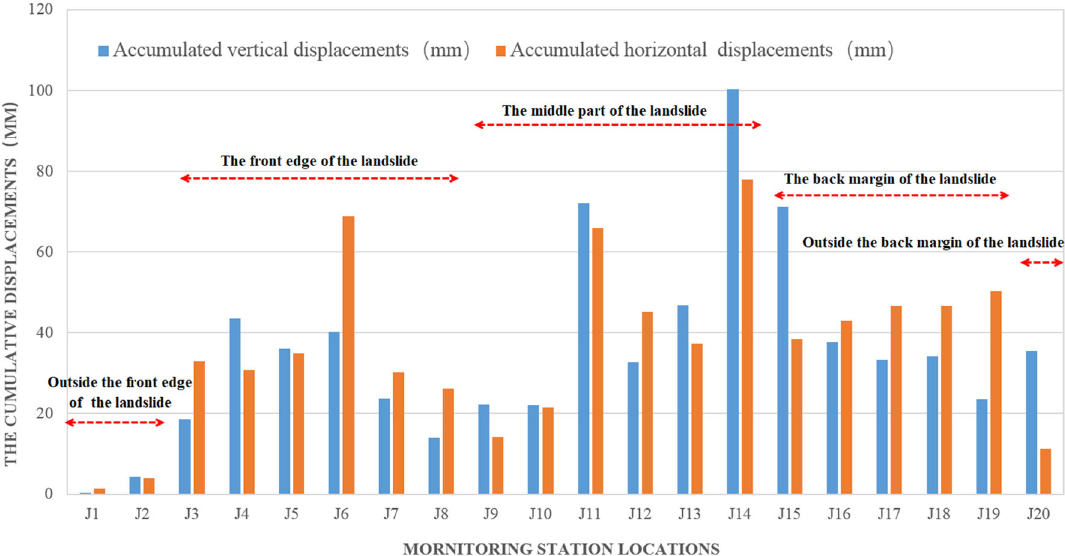
Fig. 4 Emergency monitoring at the surface of the 2013 Sunjia landslide in Wanzhou County from 5 April to 31 August 2013. The locations of the monitoring stations are marked by red squares in Fig.